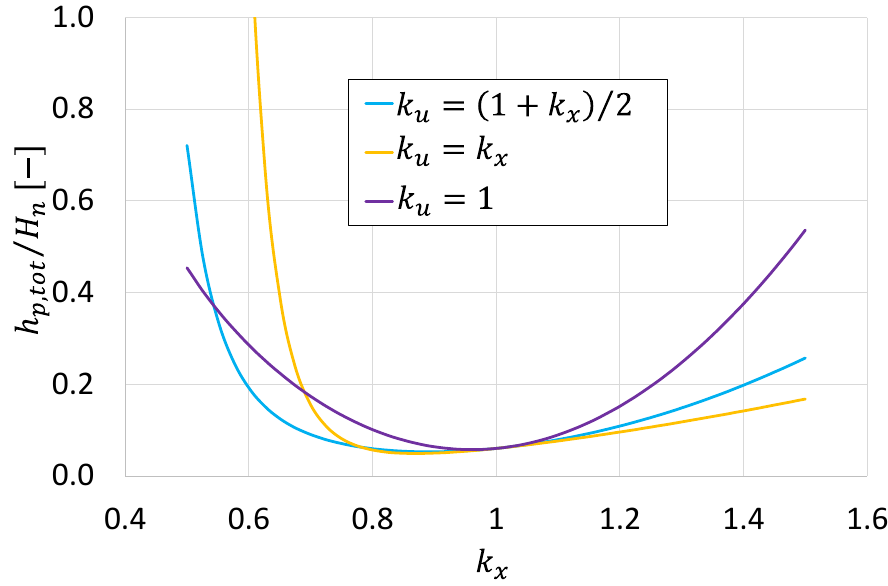
Figure 9. Normalized rotor overall meanline loss distributions overflow rate range. Cases k u = 1, k u = k x , k u = ( 1 + k x )/2.